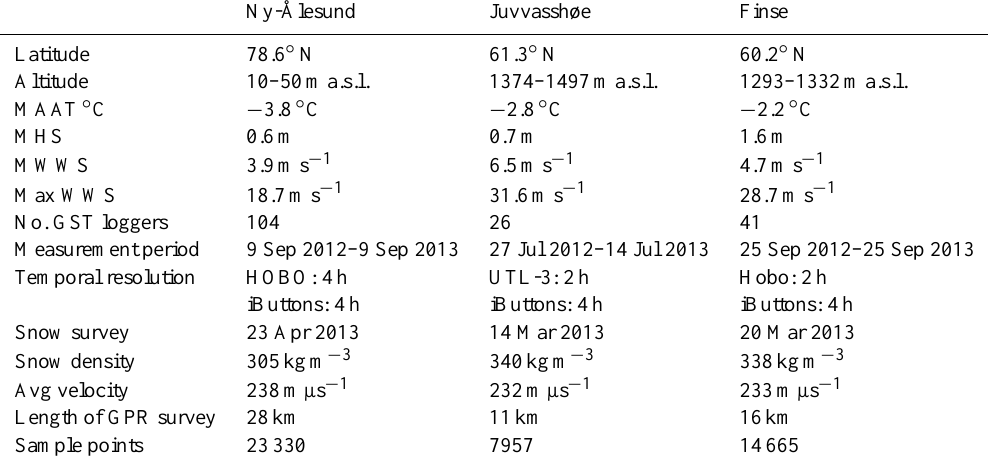
Table 1. Site and climate characteristics for the measurement period 2012–2013. MAAT is the annual mean air temperature in the field area. MHS: average snow height in the terrain at snow maximum; MWWS: mean winter (Dec–Mar) wind speed; MaxWWS: maximum winter (Dec–Mar) wind speed. Wind speed at Juvvasshøe is measured at the meteorological station at the top of Juvvasshøe